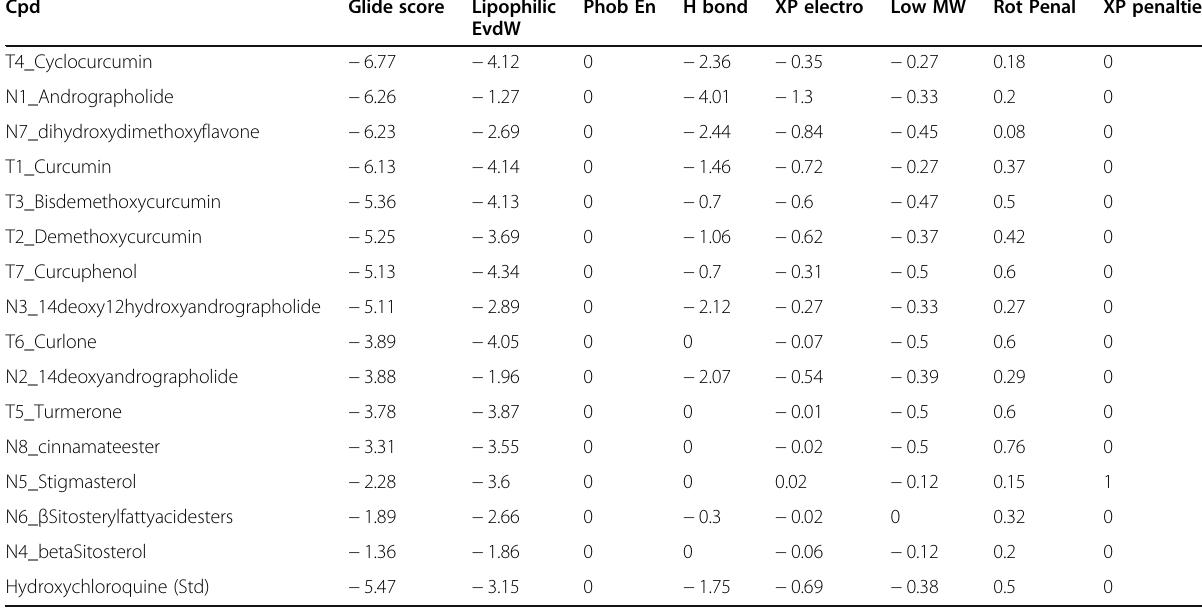
Table 1 Docking studies for phytochemical constituents of Curcuma longa (turmeric) and Andrographis paniculata with SARS CoV-2 main protease (5R82)